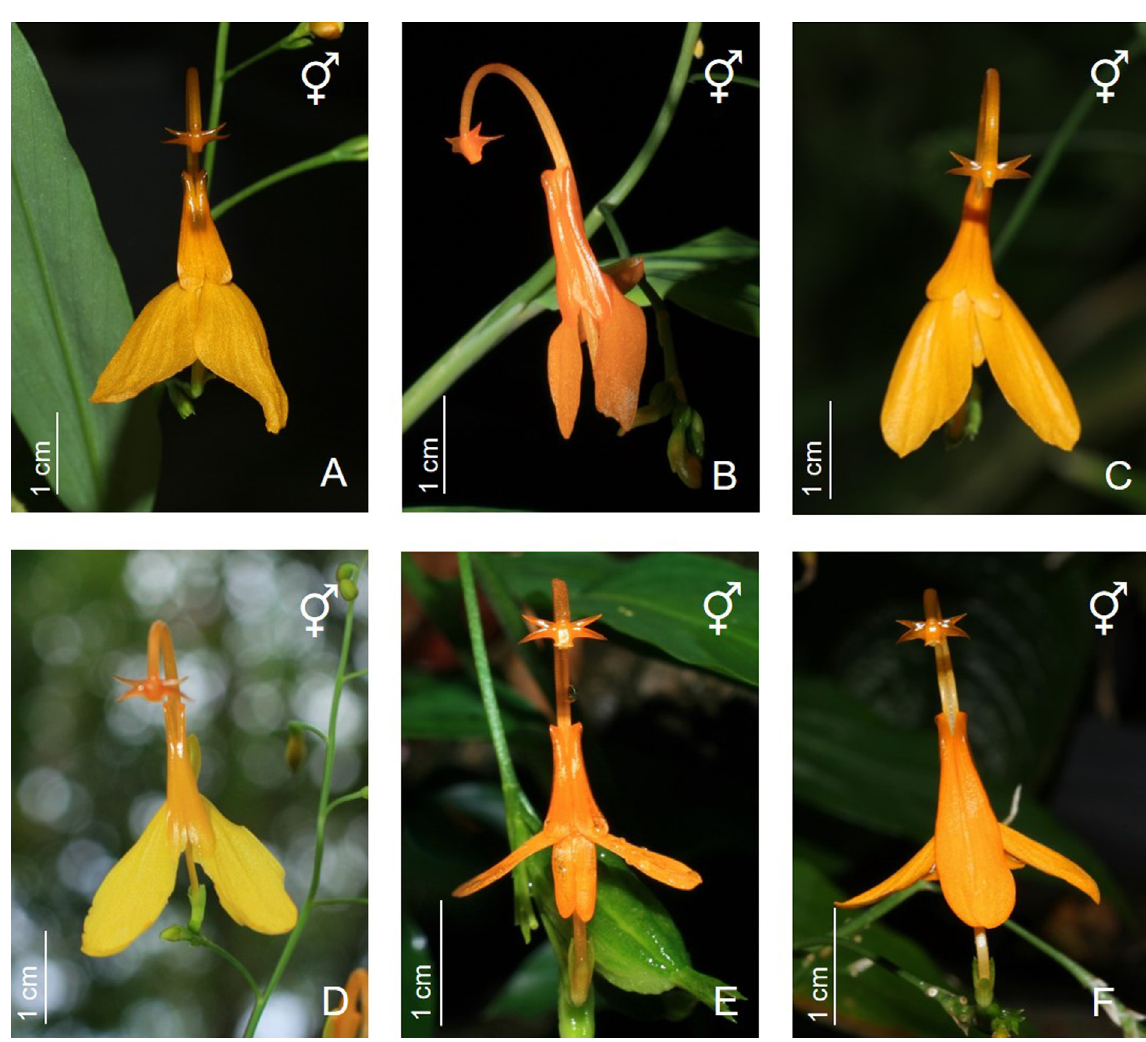
Fig. 2. Globba subsect. Nudae K.Larsen. A . G. aranyaniae Sangvir. & M.F.Newman sp. nov. (S. Sangvirotjanapat 785 leg.). B . G. expansa Wall. ex Horan. (M.F. Newman 2561 leg.). C . G. flagellaris K.Larsen (M.F. Newman and JLS 2048 leg.). D . G. insectifera Ridl. (S. Sangvirotjanapat s.n. leg.). E . G. lithophila Sangvir. & M.F.Newman sp. nov. (M.F. Newman 2576 leg.). F . G. macrochila Sangvir. & M.F.Newman sp. nov. (S. Sangvirotjanapat 795 leg.). Photographs: S.